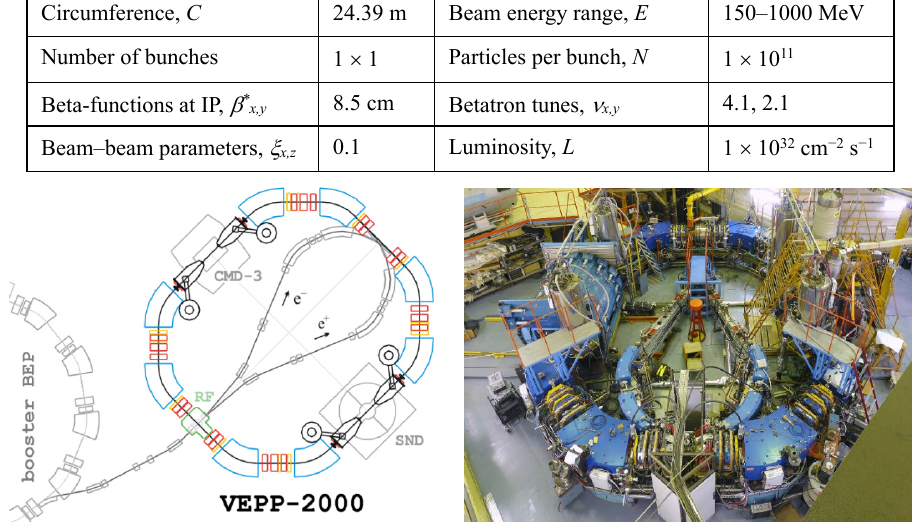
Fig. 3. VEPP-2000 schematic layout (left) and photo